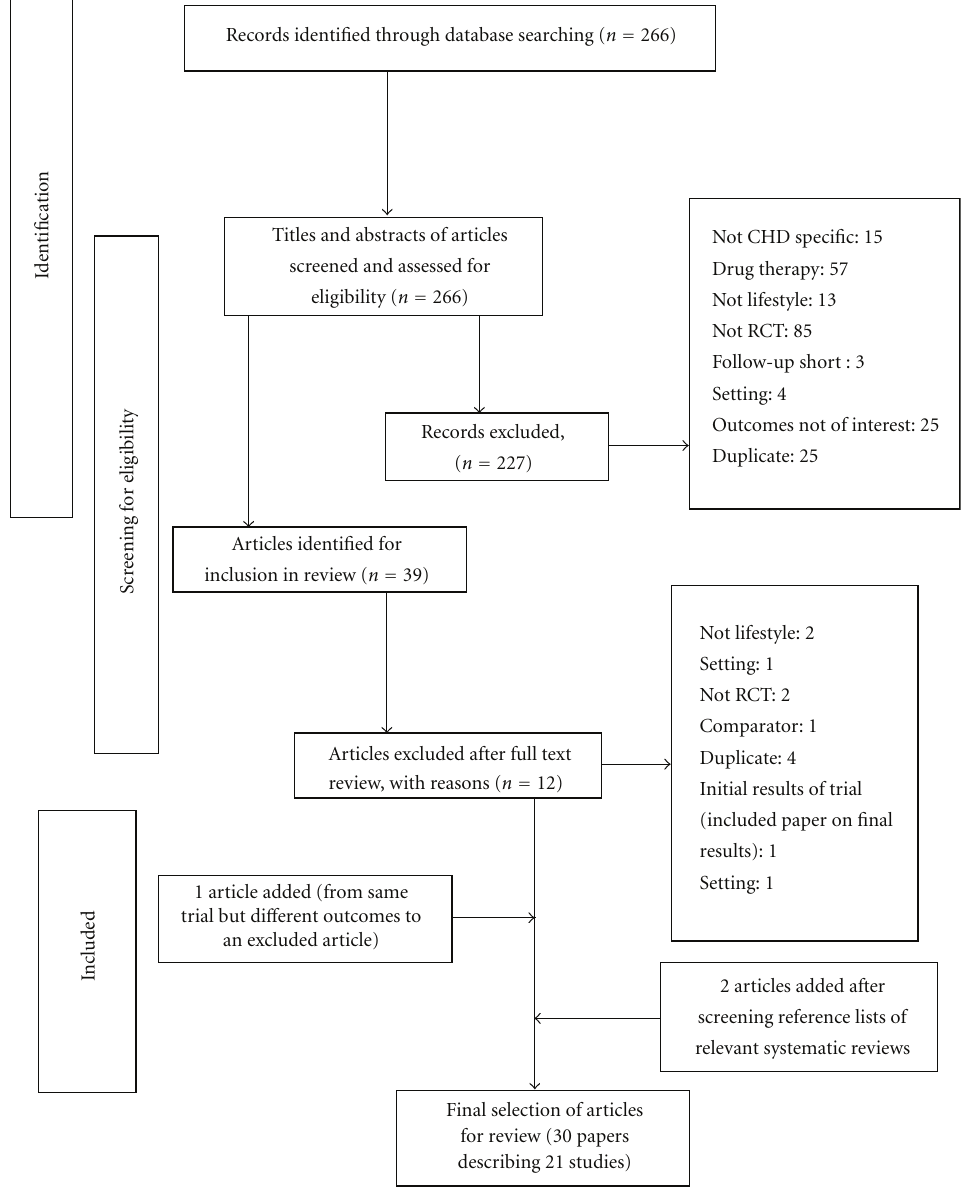
Figure 1: Screening and selection of studies of interventions for secondary prevention of coronary heart